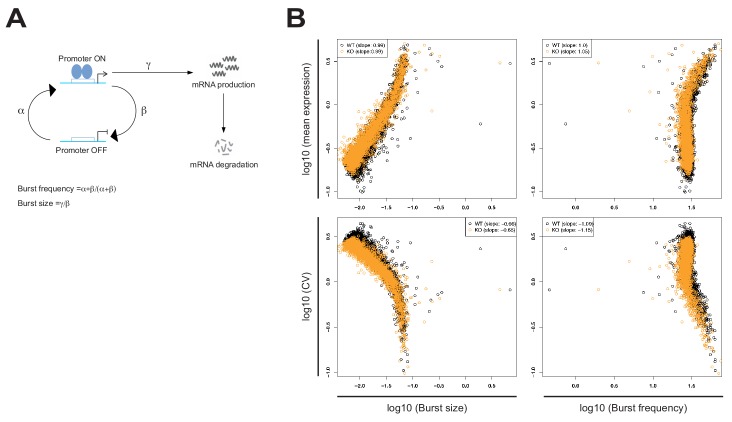
Differential transcriptional heterogeneity in Kat2a WT and KO MLL-AF9 primary leukemias.(A) Stochastic two-state promoter model of gene expression. The model depicts stochastic switching between ON and OFF promoter states, with parameterization (α, β, γ and their use for estimation of burst size and frequency) as per the published D3E algorithm. The gene is transcribed in the ON state at a given burst frequency (frequency of OFF to ON promoter switches) and produces a given number of mRNA copies per burst (burst size). (B) Multiple linear regression analysis of the relationship between mean and coefficient of variation (CV) of gene expression against burst size and burst frequency in Kat2a WT and Kat2a KO leukemias. Absolute slope values reflect extent of contribution to mean expression and CV; slope value signal indicates direction of contribution. All values are significant at p-value<0.001, as computed by multiple linear regression.Figure 3—figure supplement 1—source code 1.Multiple linear regression analysis - R-language code and input data, source code for Figure 3—figure supplement 1.